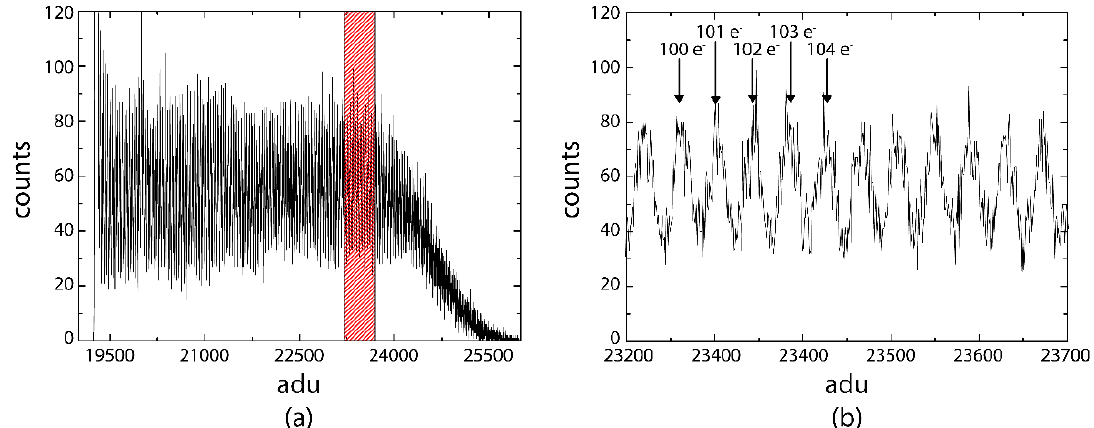
Figure 10 . By continuously extending the exposure time of the DEPFET to a faint light source, a spectrum, which includes all photon numbers, can be induced. At an average of 120 electrons the exposure time was not increased any further, resulting in a Gaussian-shaped intensity drop for higher electron numbers ( a ). In the close-up view ( b ) of the red hatched area, well separated peaks can be seen and individual electrons can be counted even for high electron numbers.